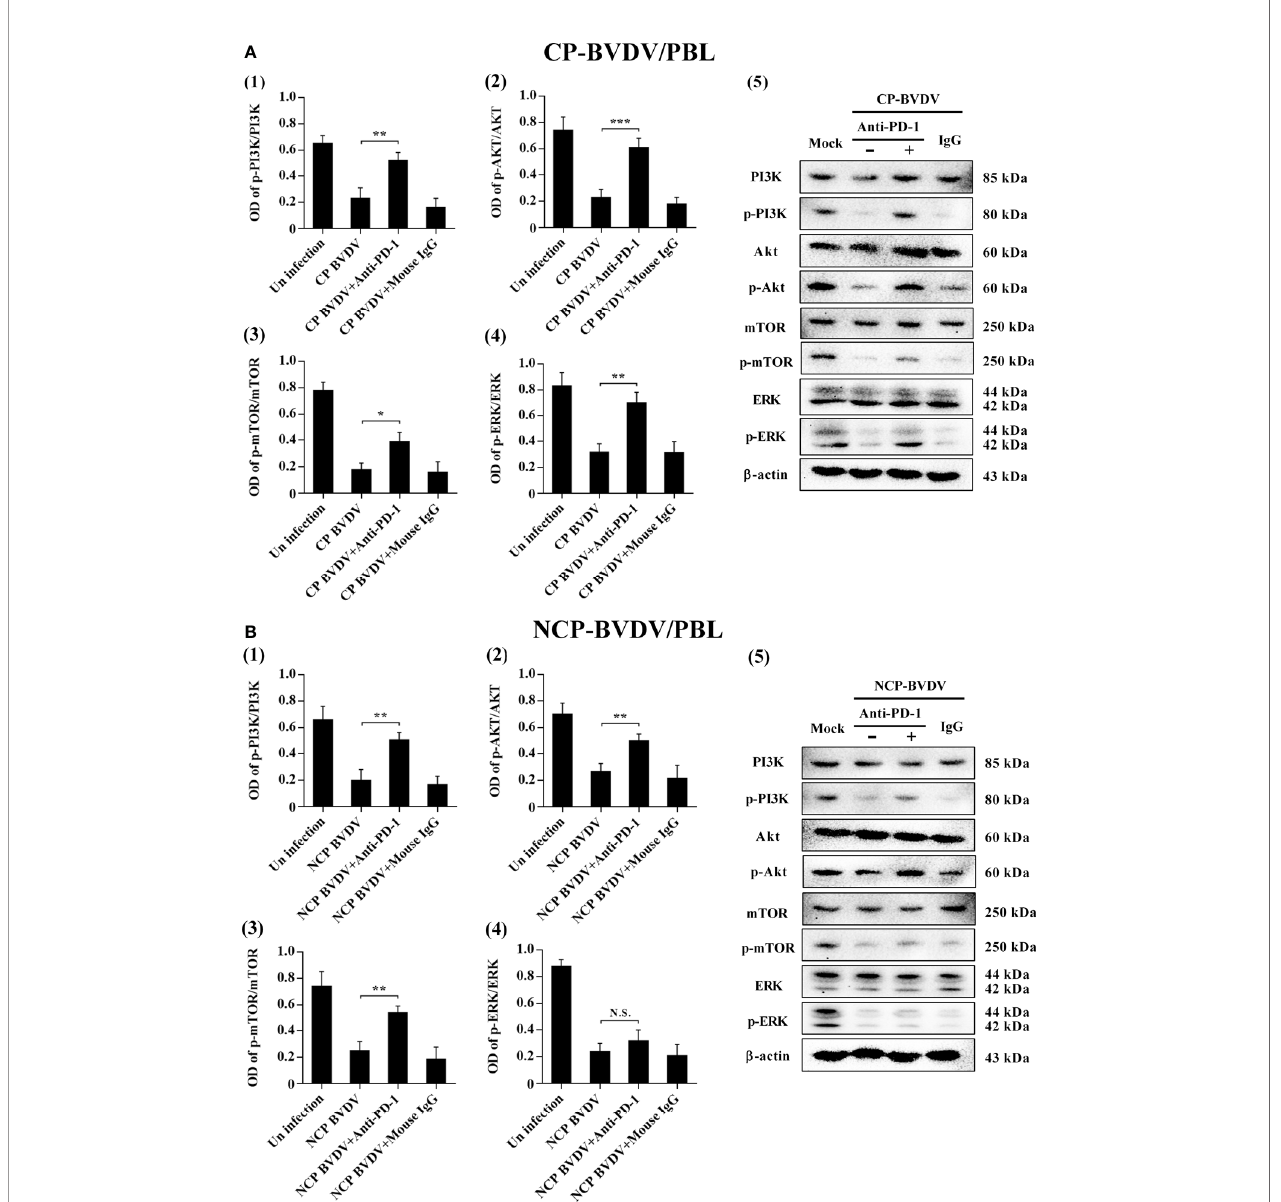
FIGURE 14 | Effectof PD-1 blockadeon the PD-1 downstream signaling molecules inPBLfromBVDV-infected mice. (A) shownare the results of densitometricanalyses of the levelsofp-PI3K(1), p-Akt(2),p-mTOR (3), p-ERK (4)in bar graphformat as wellas the representative results (5) of WesternblotanalysisofPI3K, p-PI3K,Akt, p-Akt, mTOR,p-mTOR,ERK, p-ERK, and b -actin inCP BVDV-infected mice. (B) shown are the results ofdensitometric analyses of the levelsofp-PI3K(1), p-Akt(2),p-mTOR (3), p-ERK(4) inbar graph format as wellas the representative results (5) of Western blot analysis of PI3K,p-PI3K, Akt, p-Akt, mTOR, p-mTOR, ERK, p-ERK, and b -actin in NCP BVDV-infected mice. *** p < 0.001, ** p < 0.01, * p < 0.05, NS, not signi fi cant. The animalswere assigned into 7 experimental groups, including the mock-infected group, CP BVDV-infected group, CP BVDV+anti-PD-1 group,CP BVDV+mouse IgG group, NCP BVDV-infected group, NCP BVDV+anti-PD-1 group, and NCP BVDV+mouse IgG group. CP andNCP BVDV-infectedmice were used as the controls. Data are presented as mean ± SD (n= 5 per group) andanalyzed using one-way